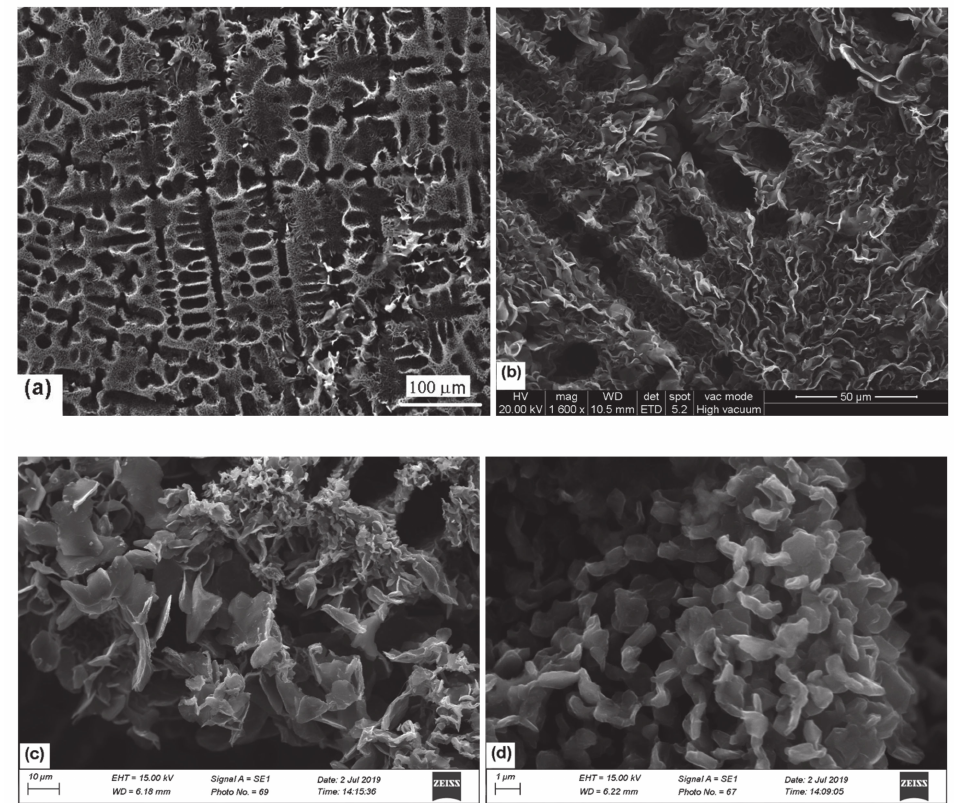
Figure 4. SEM images of the AEG-LDG that was tested in Li-O 2, at four different magnifications: ( a ) Field view of AEG-LDG; ( b ) Quasi-cylindrical channels left by the dissolved matrix; ( c ) Transition from LDG to another finer LG; ( d ) Detail of the finer LG.